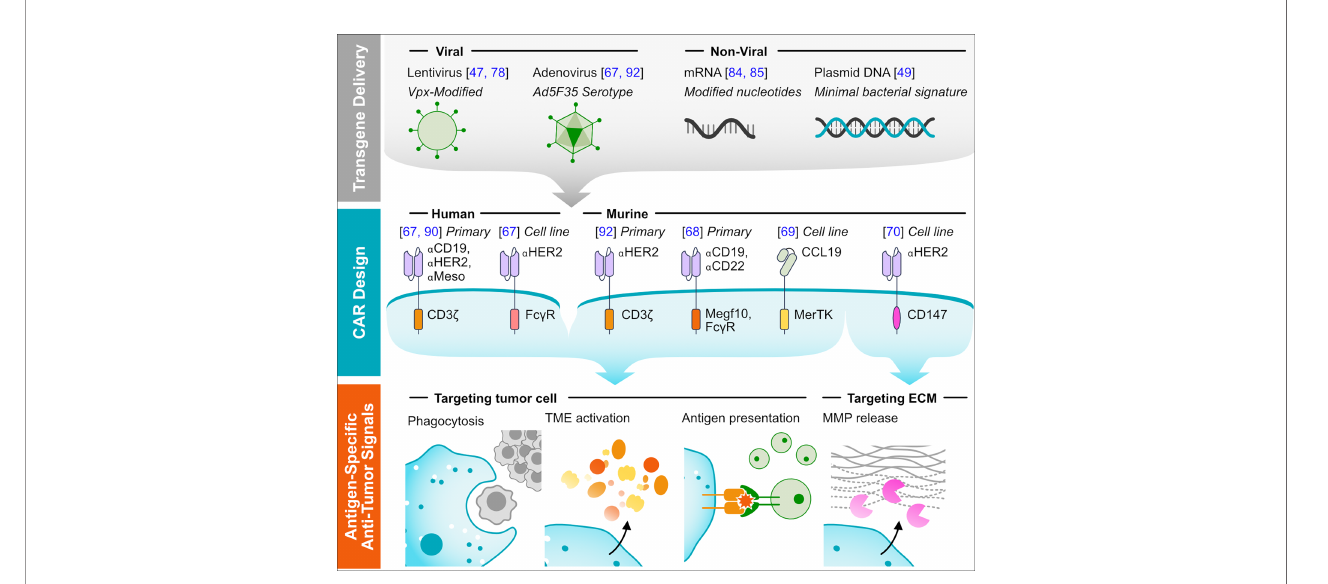
FIGURE 1 | Methods of targeting tumors using CAR-M. (Top) Representative viral and non-viral methods for delivering transgenes to macrophages are listed. (Middle) Representative CAR designs that have been functionally validated in macrophages, with annotated antigen-targeting and cytosolic domains. The system in which the receptors were validated is noted: either human or murine, testing with primary cells or exclusively with immortalized cell lines. (Bottom) Major mechanisms of tumor clearance by